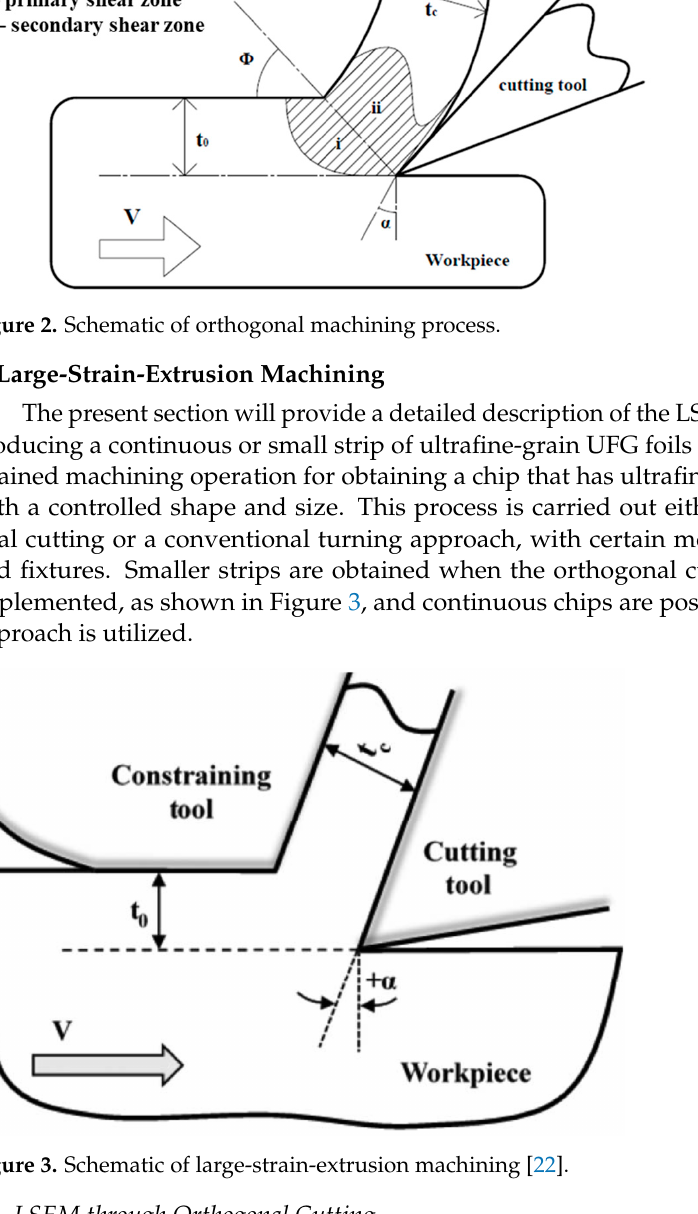
Figure 3. Schematic of large-strain-extrusion machining [22].